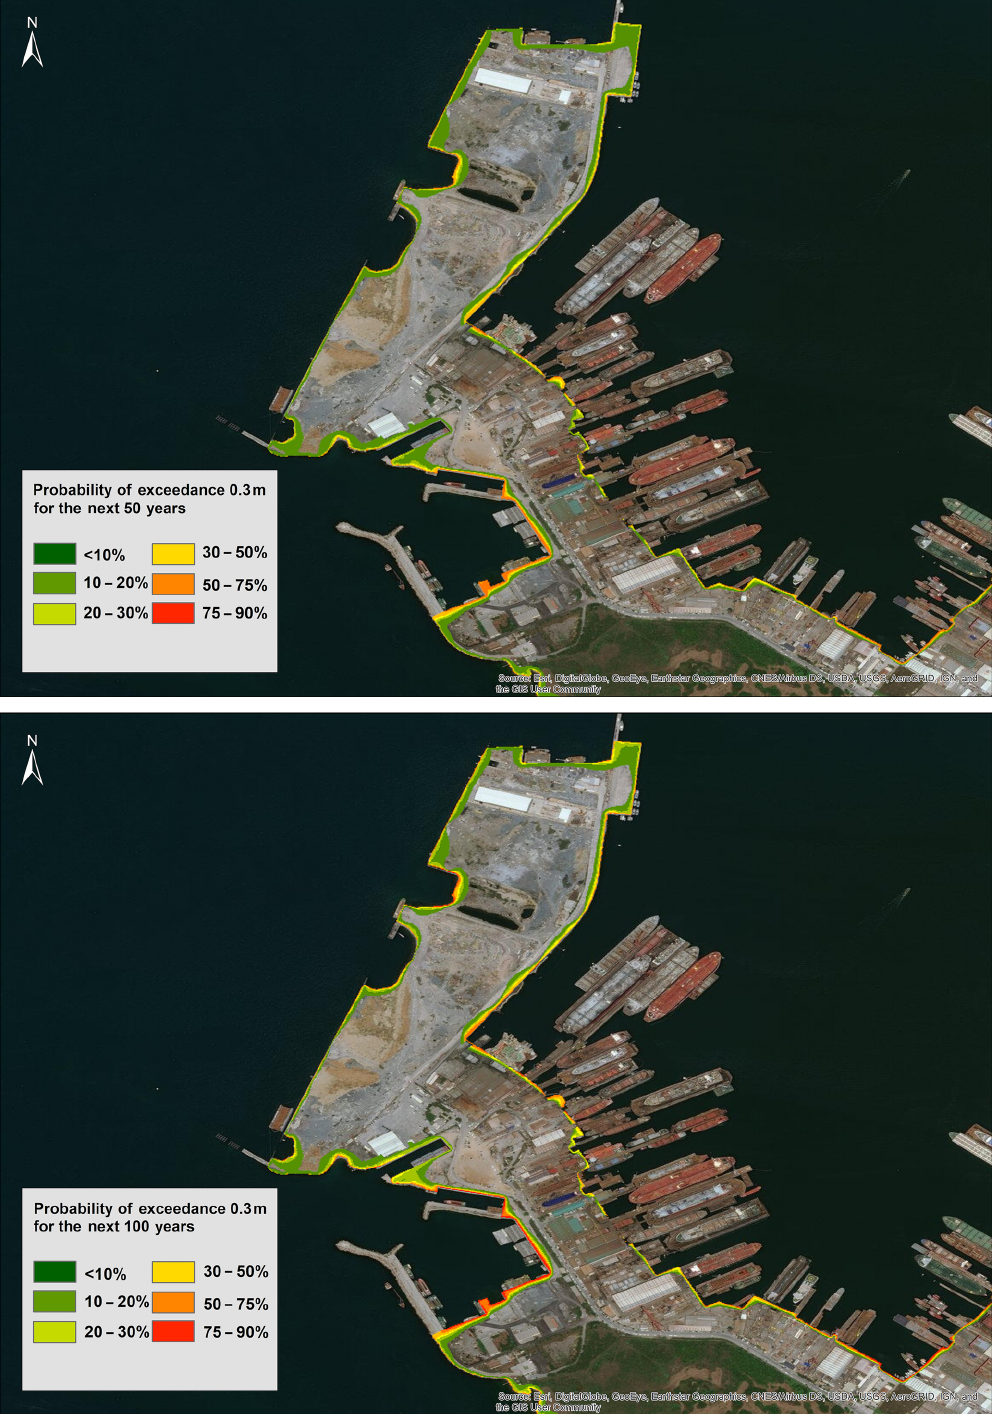
Figure 10. Probabilistic tsunami inundation maps for the southern part of the Tuzla study domain representing the probability of exceedance of 0.3m inundation depth for the next 50 and 100 years. Change of colors from green to red represents the increasing probability of ex- ceedance (created using ArcMap version